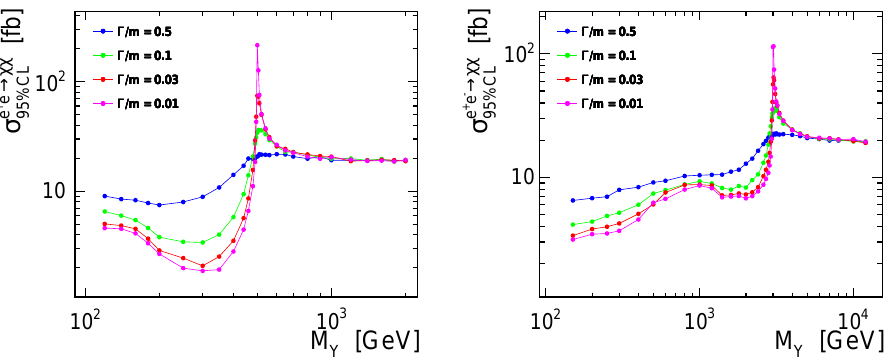
Figure 4: Limits on the total DM pair-production cross section for processes with vector mediator exchange, for different mediator widths, at 500 GeV ILC (left) and 3 TeV CLIC (right).